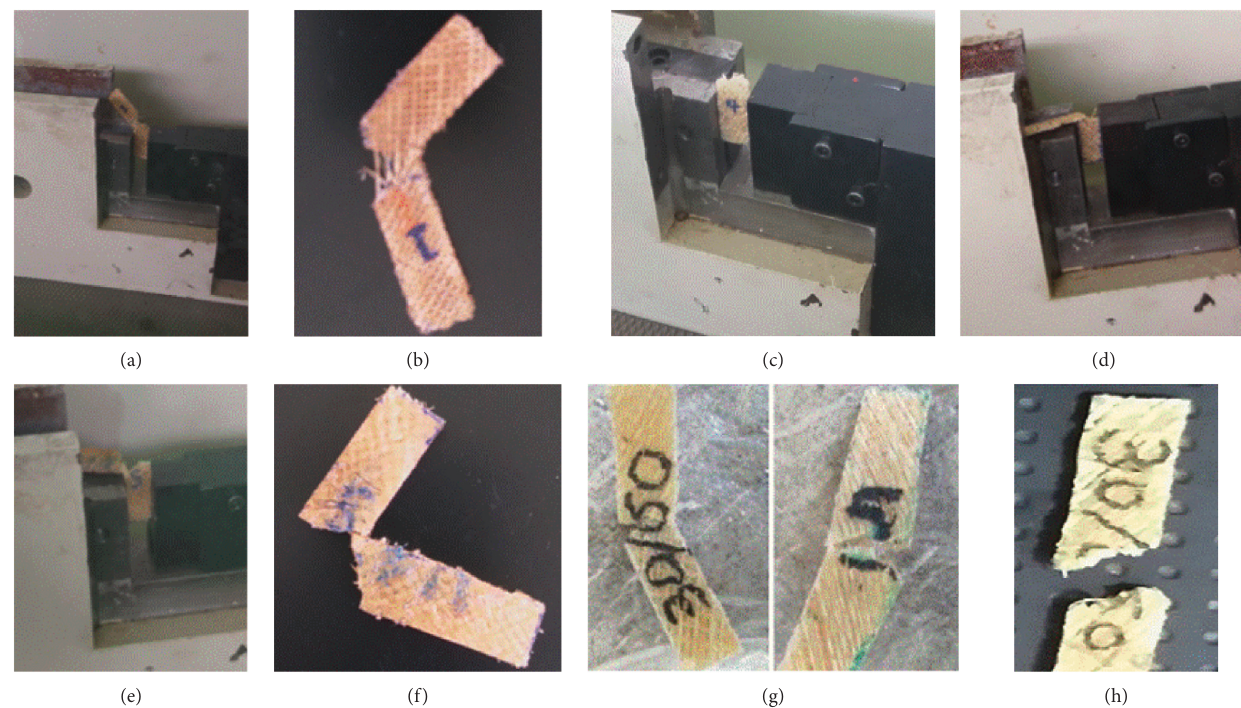
Figure 9: (a), (b), (e) and (f) 45 ° /45 ° test specimen fiber breakage; (c) and (d) 30 ° /45 ° test specimen fiber breakage; (g) and (h) 30 ° /60 ° test specimen fiber breakage.